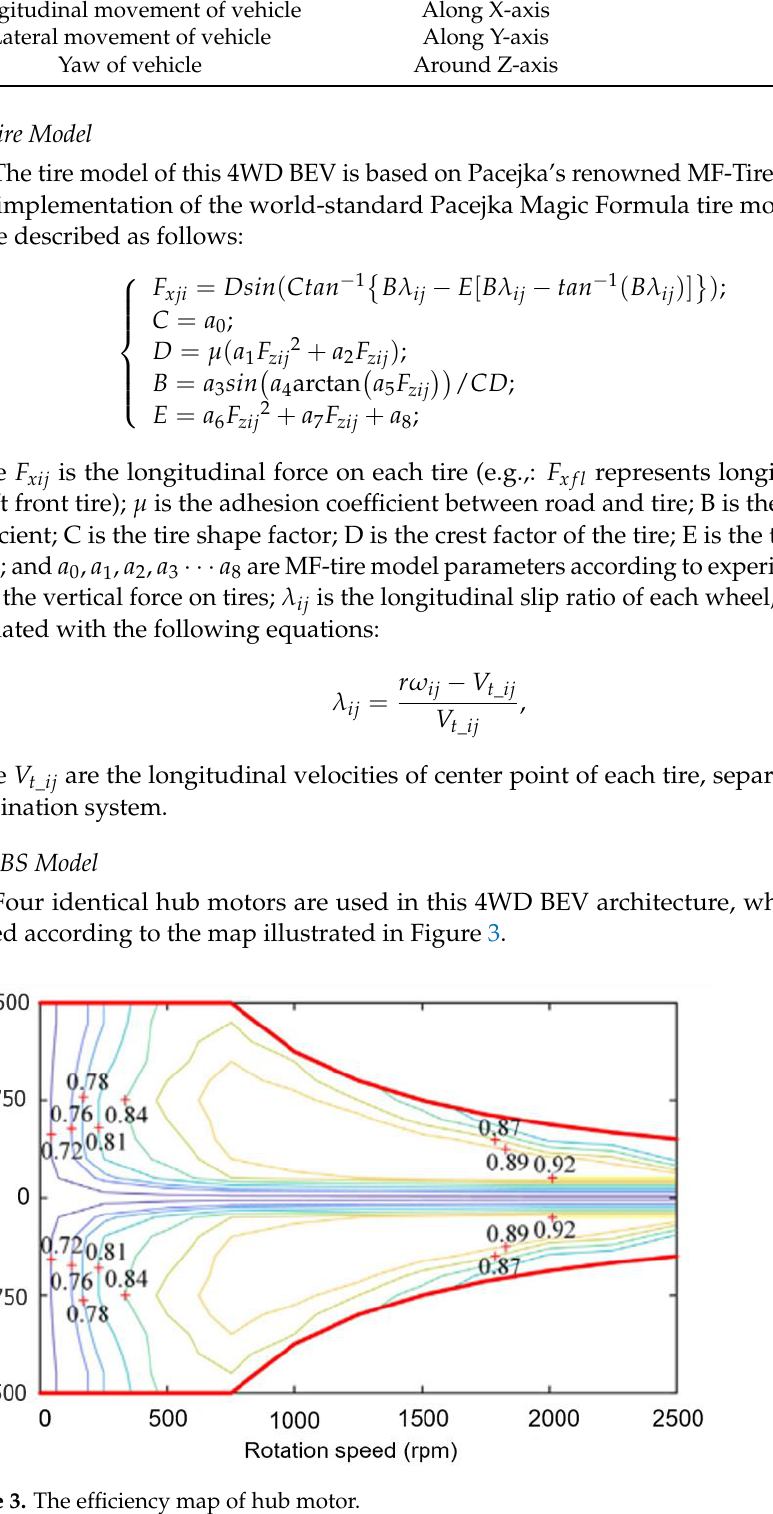
Figure 3. The efficiency map of hub motor.